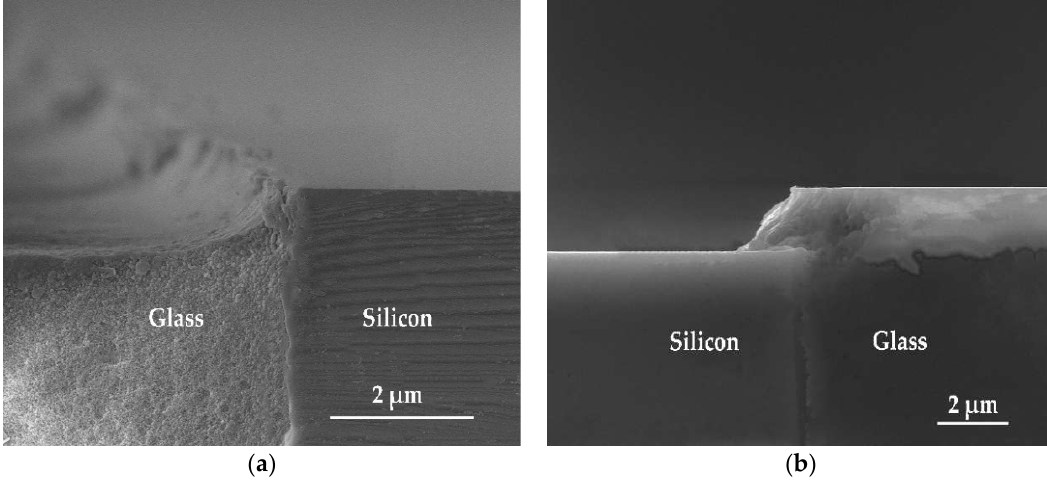
Figure 6. SEM cross-sectional views for silicon-glass interfaces. ( a ) Only glass was etched by HF-based solution with added HCl; ( b ) only silicon was etched by inductively coupled plasma (ICP).